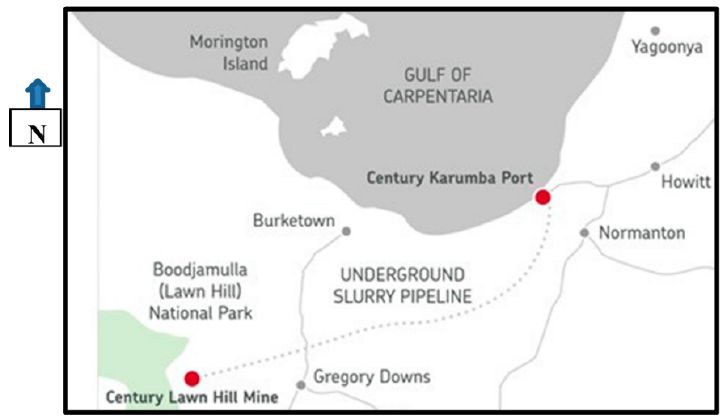
Figure 1. Map showing location of OZ Mineral’s Century Mine, the slurry pipeline and the Karumba Port Operations. The pipeline runs for 304 km.